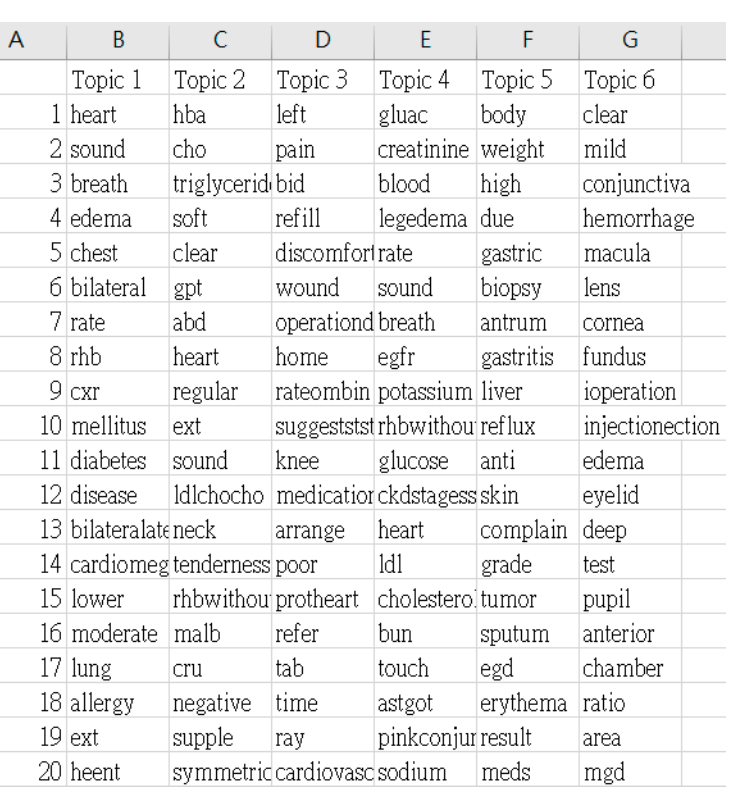
Figure 9. List of words for each topic (E11).